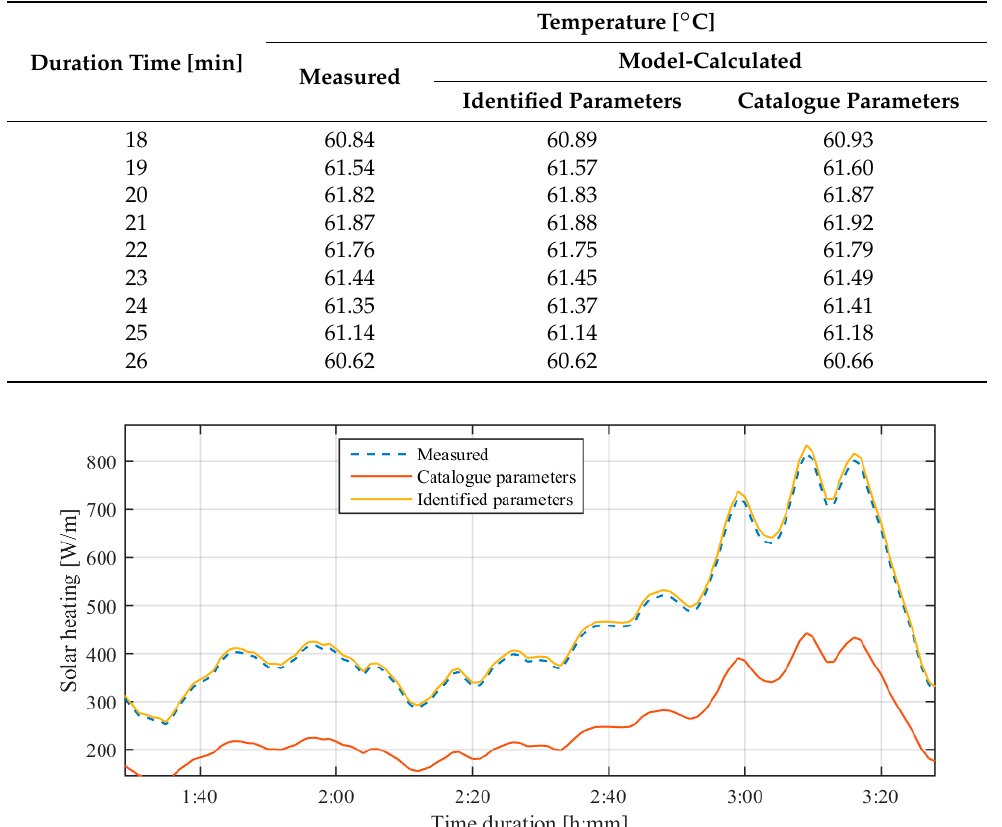
Figure 7. Measured (blue dashed line) and calculated solar heating using catalogue parameters (red line) and parameters determined by the proposed optimization procedure (yellow line).